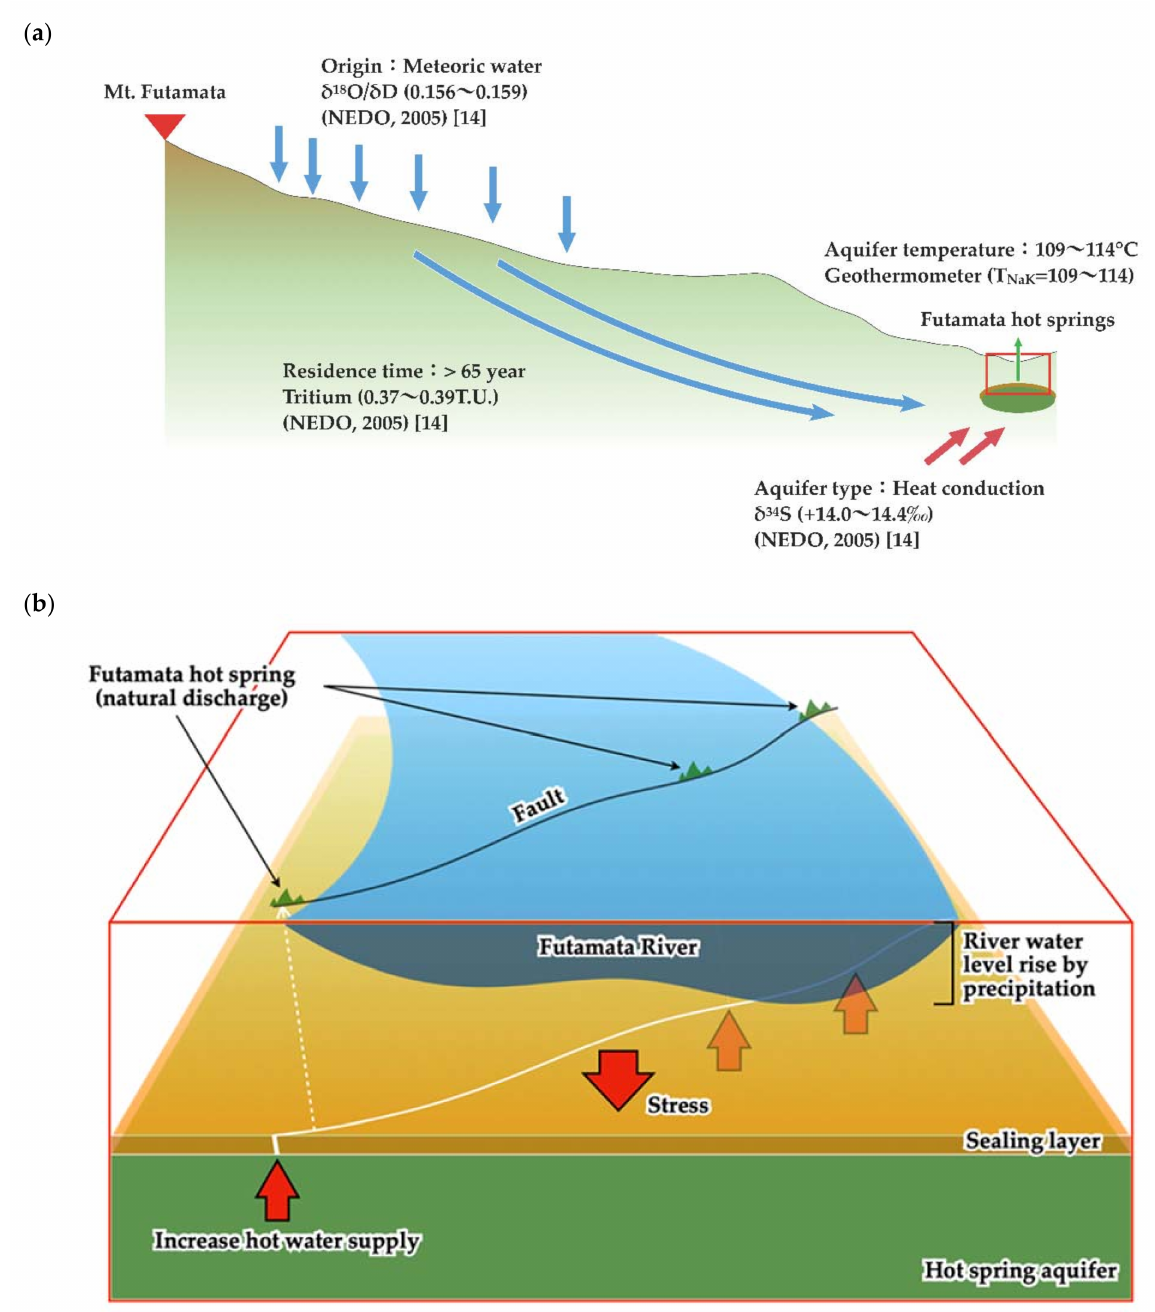
Figure 9. Discharge mechanism of the Futamata hot spring. ( a ) Static model. Meteoric water on the hillside of Mt. Futamata penetrates underground and emerges as Futamata hot spring after a residence time of approximately over 65 years. ( b ) Dynamic model. The underground stress field changes because of the increase in the flow rate of the Futamata River with the occurrence of precipitation, and hot water is pushed out from the aquifer that exists in the shallow part of the Futamata